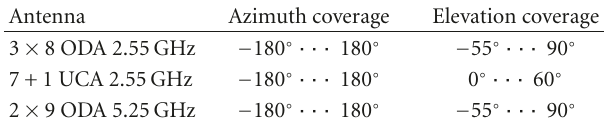
Table 3: Antenna